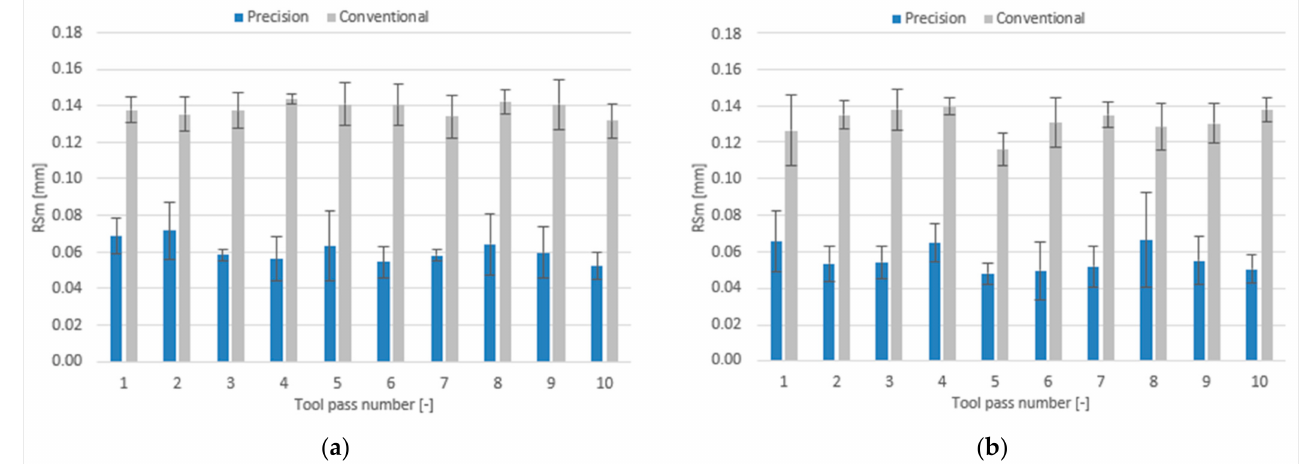
Figure 20. Milling conditions versus surface roughness parameter RSm in the milling process conducted using a tool coated with: ( a ) TiB 2 and ( b ) TiAlN.